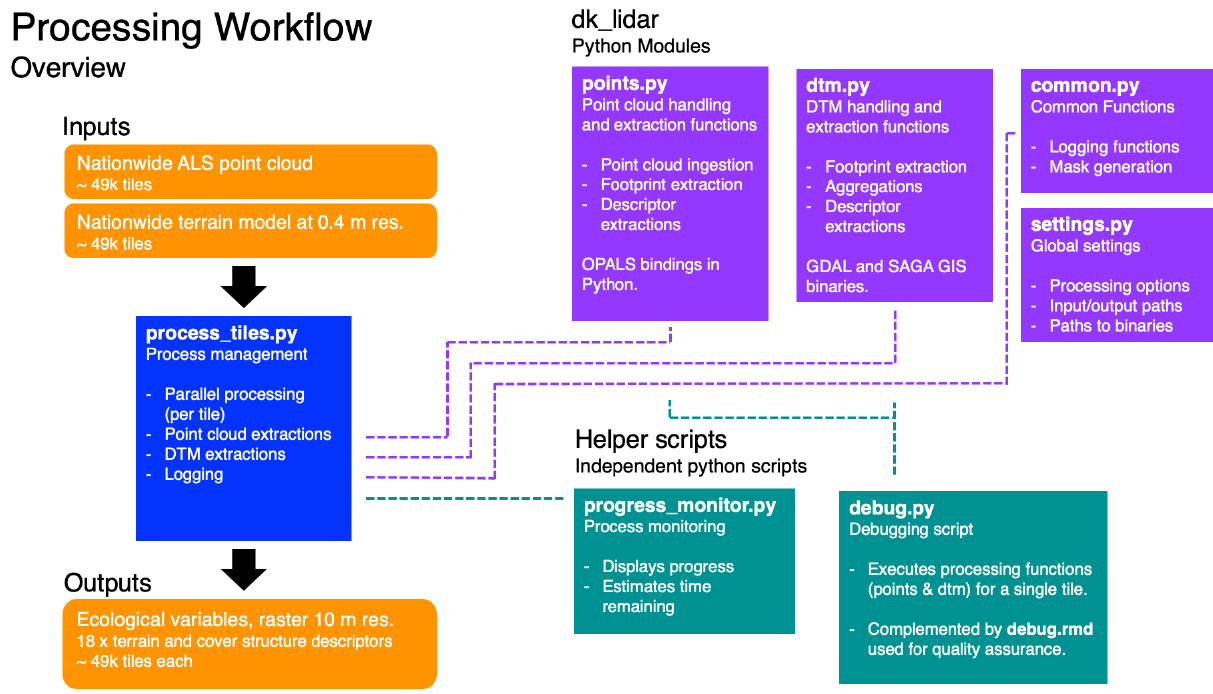
Figure 1. Diagram of the processing workflow, the dk_lidar Python module and helper scripts. The workflow requires two inputs: a pre- classified set of point cloud tiles and a paired set of digital terrain model (DTM) tiles. The process management is handled by the pro- cess_tiles.py script which facilitates processing of each tile pair (DTM and point cloud) in parallel and logs the progress. For each tile, process_tiles.py calls a specified set of extraction and processing functions from the dk_lidar modules. Point cloud extraction functions are specified in points.py and terrain model extraction functions are specified in dtm.py . The dk_lidar modules also contain two fur- ther files: common.py , a script containing specifications of common functions used by the points.py and dtm.py, , as well as settings.py , which is used to set global processing options, specify file paths, etc. Finally, two helper scripts are provided: progress_monitor.py , which facilitates progress monitoring and estimates the time remaining, and debug.py , a script for testing the workflow for a single tile. To- gether the Python scripts and modules allow the ecological descriptor outputs from the two input data sets to be generated. Further documentation of the dk_lidar modules and workflow scripts can be found on the GitHub repository associated with this publication: https://github.com/jakobjassmann/ecodes-dk-lidar (last access: 5 January 2022).